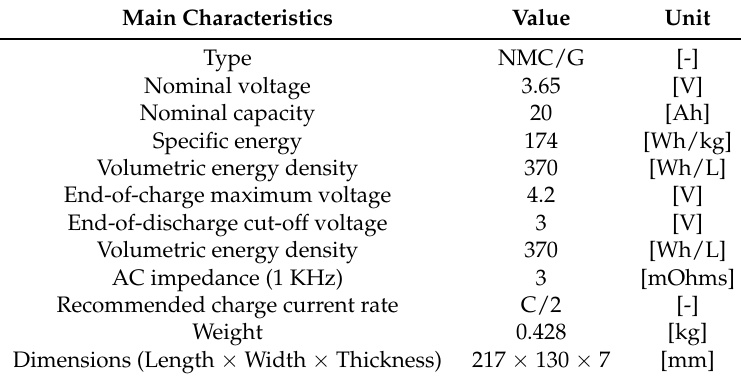
Table 1. Electromechanical properties (manufacturer). NMC pouch